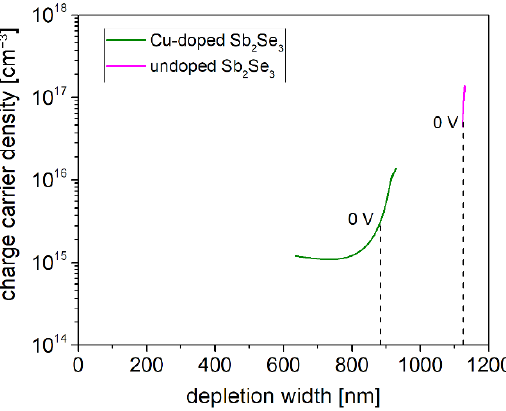
Figure 5. Free carrier profiles obtained from the d(1/C 2 )/dV at 120 K on undoped and 5% Cu-doped Sb 2 Se 3 solar cells. The test signal frequency and amplitude are 1 MHz and 35 mV, respectively.